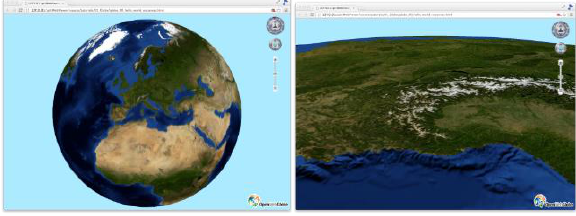
Figure 2. Mapping image data on a globe without elevation